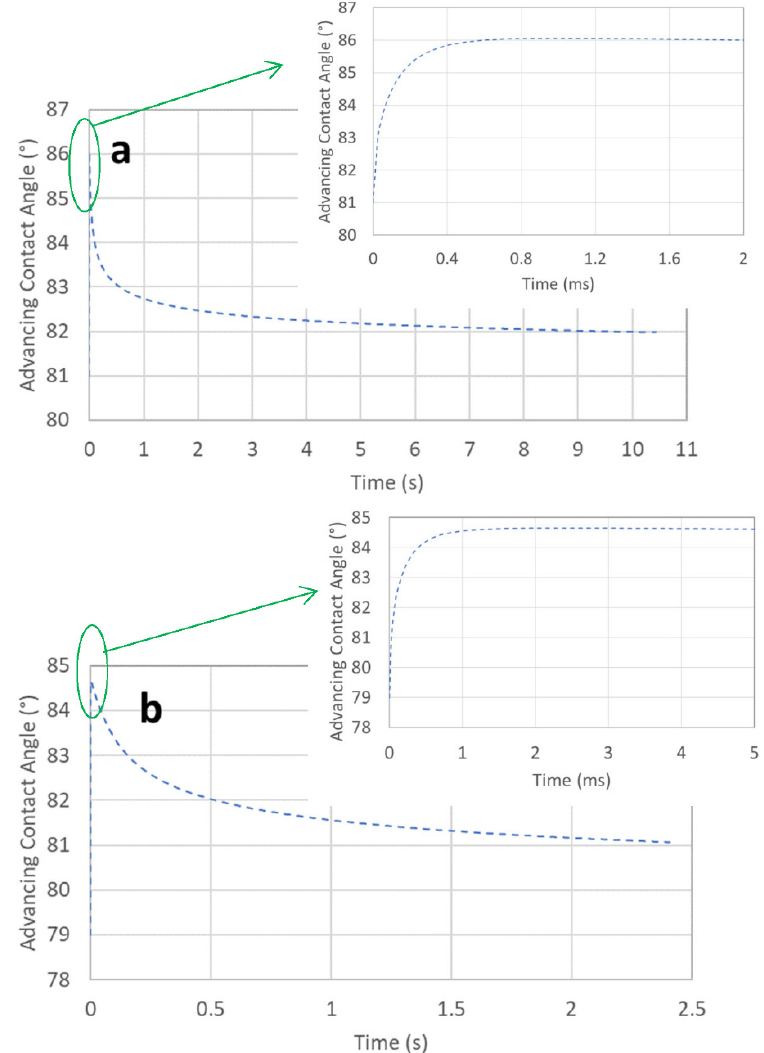
Figure 5. Advancing contact angle versus time in Model 3. Here, ( a ) and ( b ) indicate tubes of 0.5 and 1.15 mm in diameter, respectively.